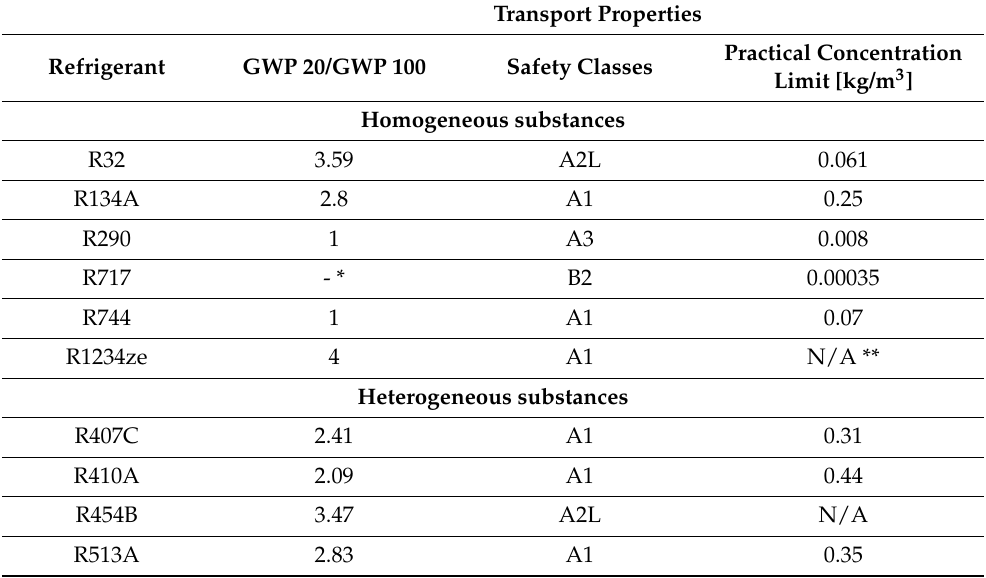
Table 9. Comparison between the GWP 20/GWP 100 ratio, safety class, and practical concentration limit for refrigerants commonly used in air-conditioning